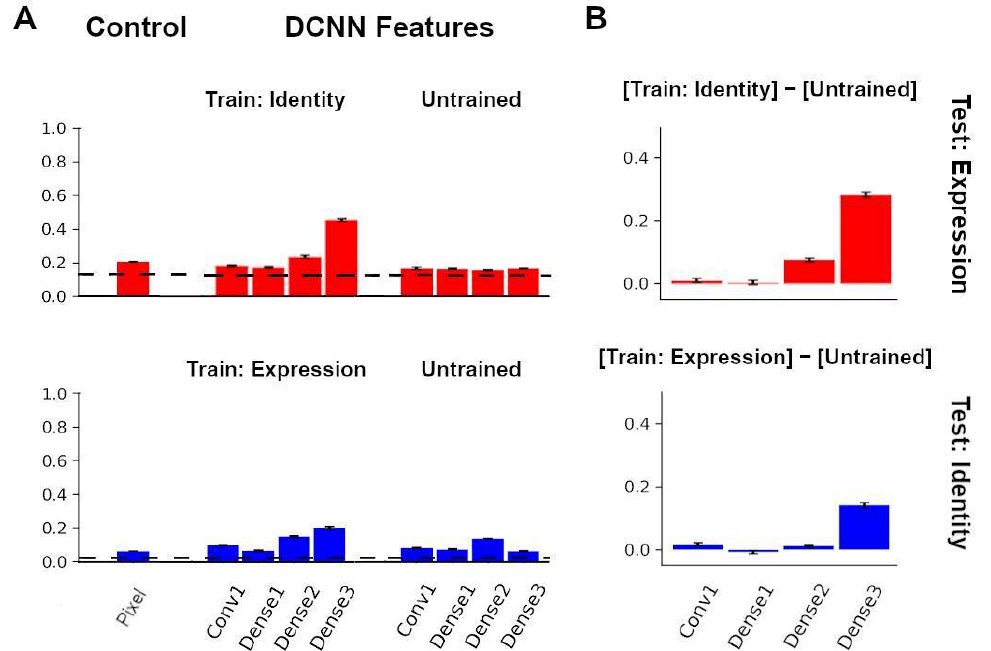
Figure 5. Comparisons with the Untrained Network. ( A ) Classification performance using identity features and untrained features for expression labeling (top) and expression features and untrained features for identity labeling (bottom). ( B ) Difference in expression classification between identity network and untrained network (top). Difference in identity classification between expression network and untrained network (bottom). Error bars in plots denote the SEM of the performance of network